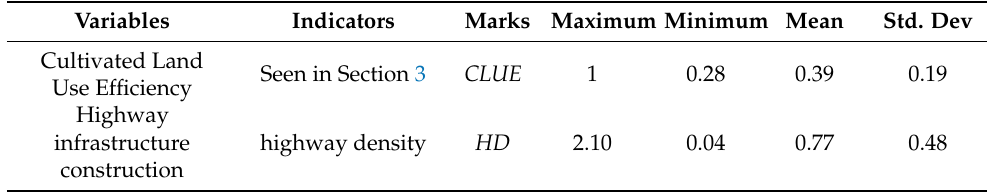
Table 3. Descriptive statistics of the